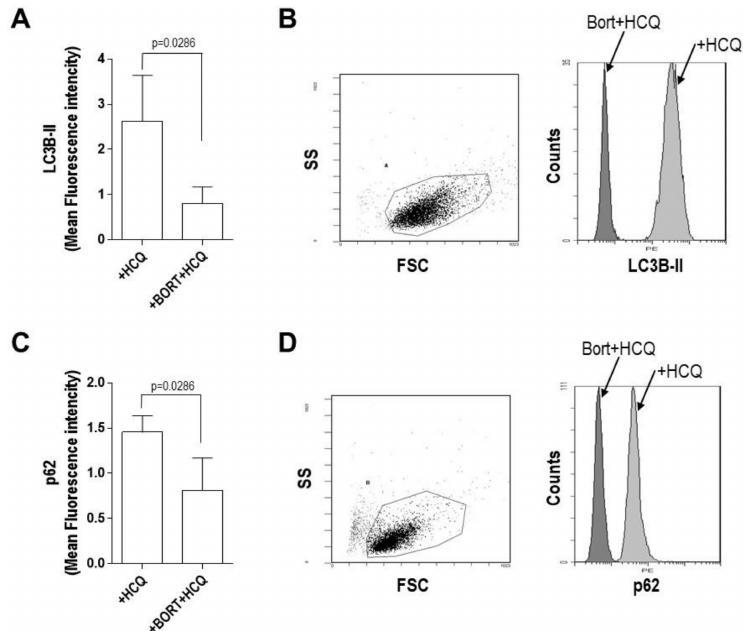
Figure 2. Bortezomib and hydroxychloroquine combination decreases autophagosome formation acting as a downregulator of autophagic flux in plasma cells (PCs). RPMI 8226 ( A ) and JJN-3 ( D ) cells were treated with or without bortezomib (10 nM), hydroxychloroquine (HCQ, 100 uM), or with both drugs for 24 h, followed by immunoblotting analysis to determine LC3B-II and p62 expression levels under each condition. Densitometric analysis of RPMI 8226 ( B , C ) and JJN-3 ( E , F ) lysates for LC3B-II ( B , E ) and p62 ( C , F ) expression. The results are expressed as fold-change normalized to the β -actin level and relative to the control. Mann–Whitney U test.